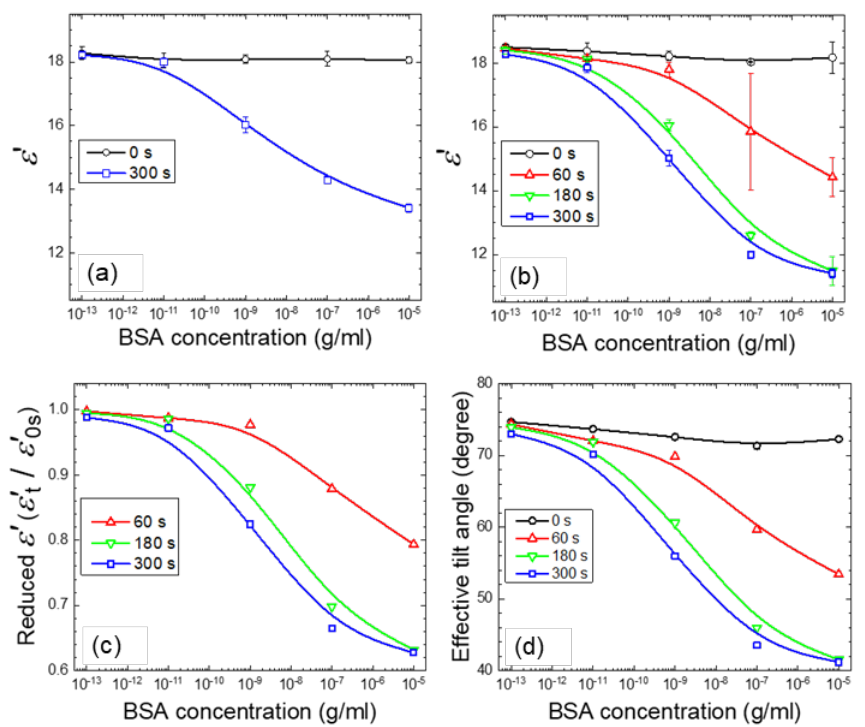
Figure 7. Dielectric spectroscopic analysis of NOA65/E7 cells exposed to 20-mW/cm 2 UV irradiation in the presence of BSA. ( a ) The real-part dielectric constant of E7 doped with 2-wt.% NOA65 and exposed to UV for 0 or 300 s. ( b ) The real-part dielectric constant, ( c ) the reduced ε ’, and ( d ) the effective tilt angle θ of E7 doped with 4-wt.% NOA65 and exposed to UV for 0, 60, 180, or 300 s as a function of the BSA concentration. The value of θ was calculated by Equation (3) based on the data retrieved from ( b ). Curves are based on spline fitting.